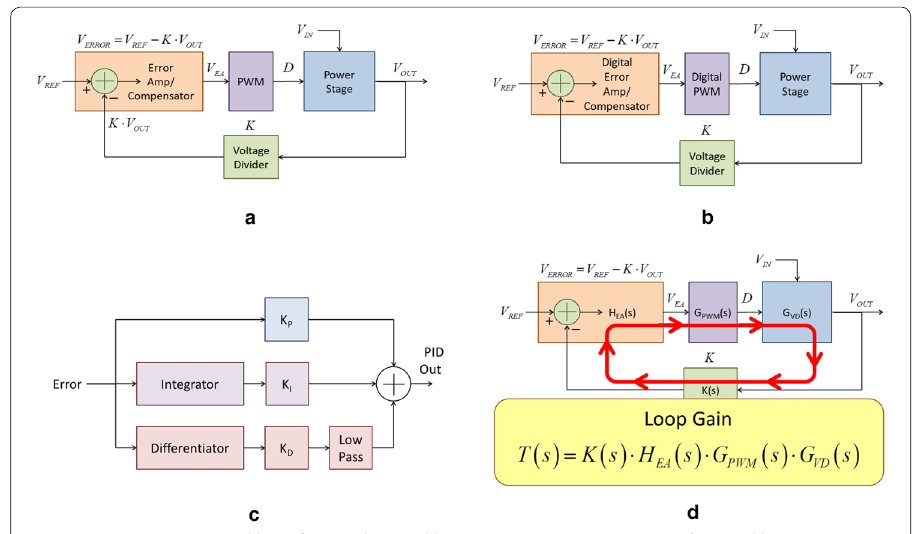
Fig. 2 a Continuous control loop. b Digital control loop. c PID/PIDN compensator. d control loop